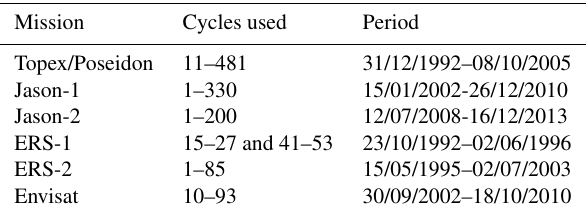
Table 1. Cycles used for the analysis of each altimeter